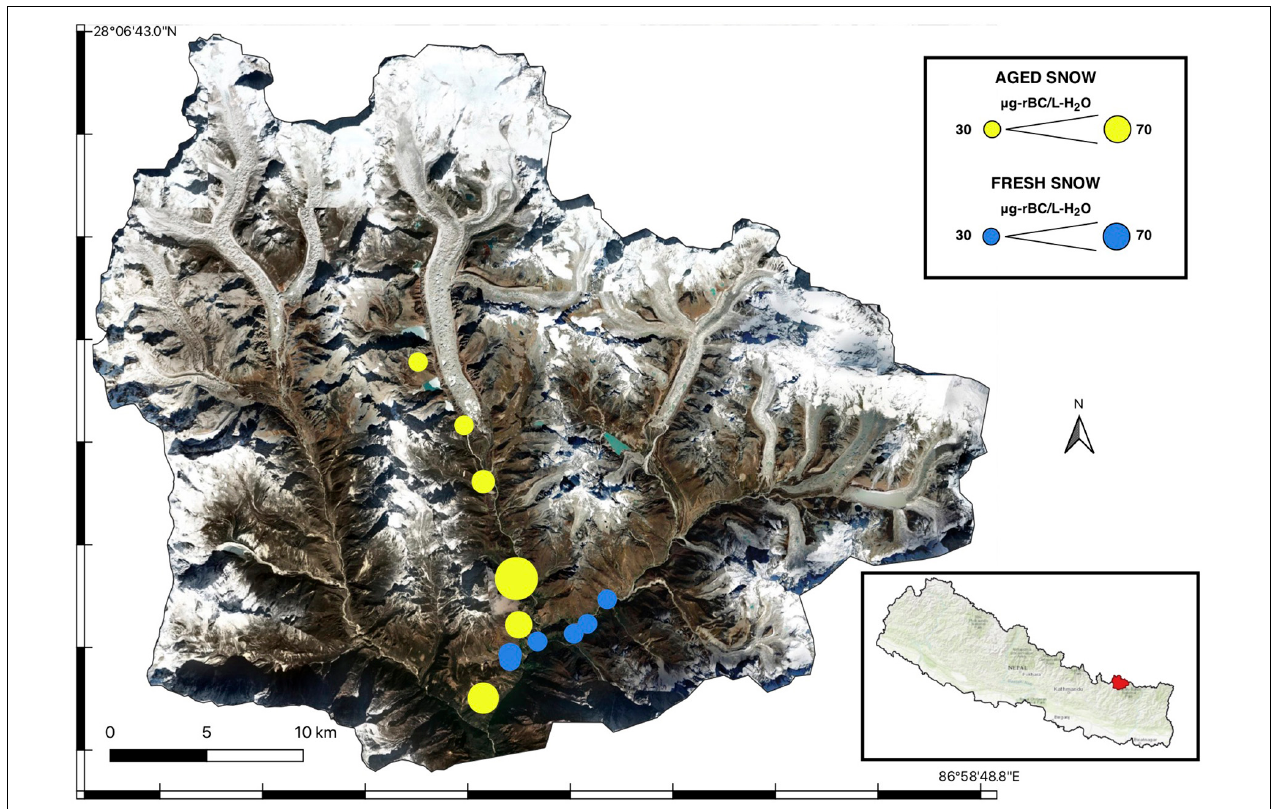
FIGURE 1 | Refractory black carbon (rBC) concentrations at sample locations in the Dudh Koshi River Basin.